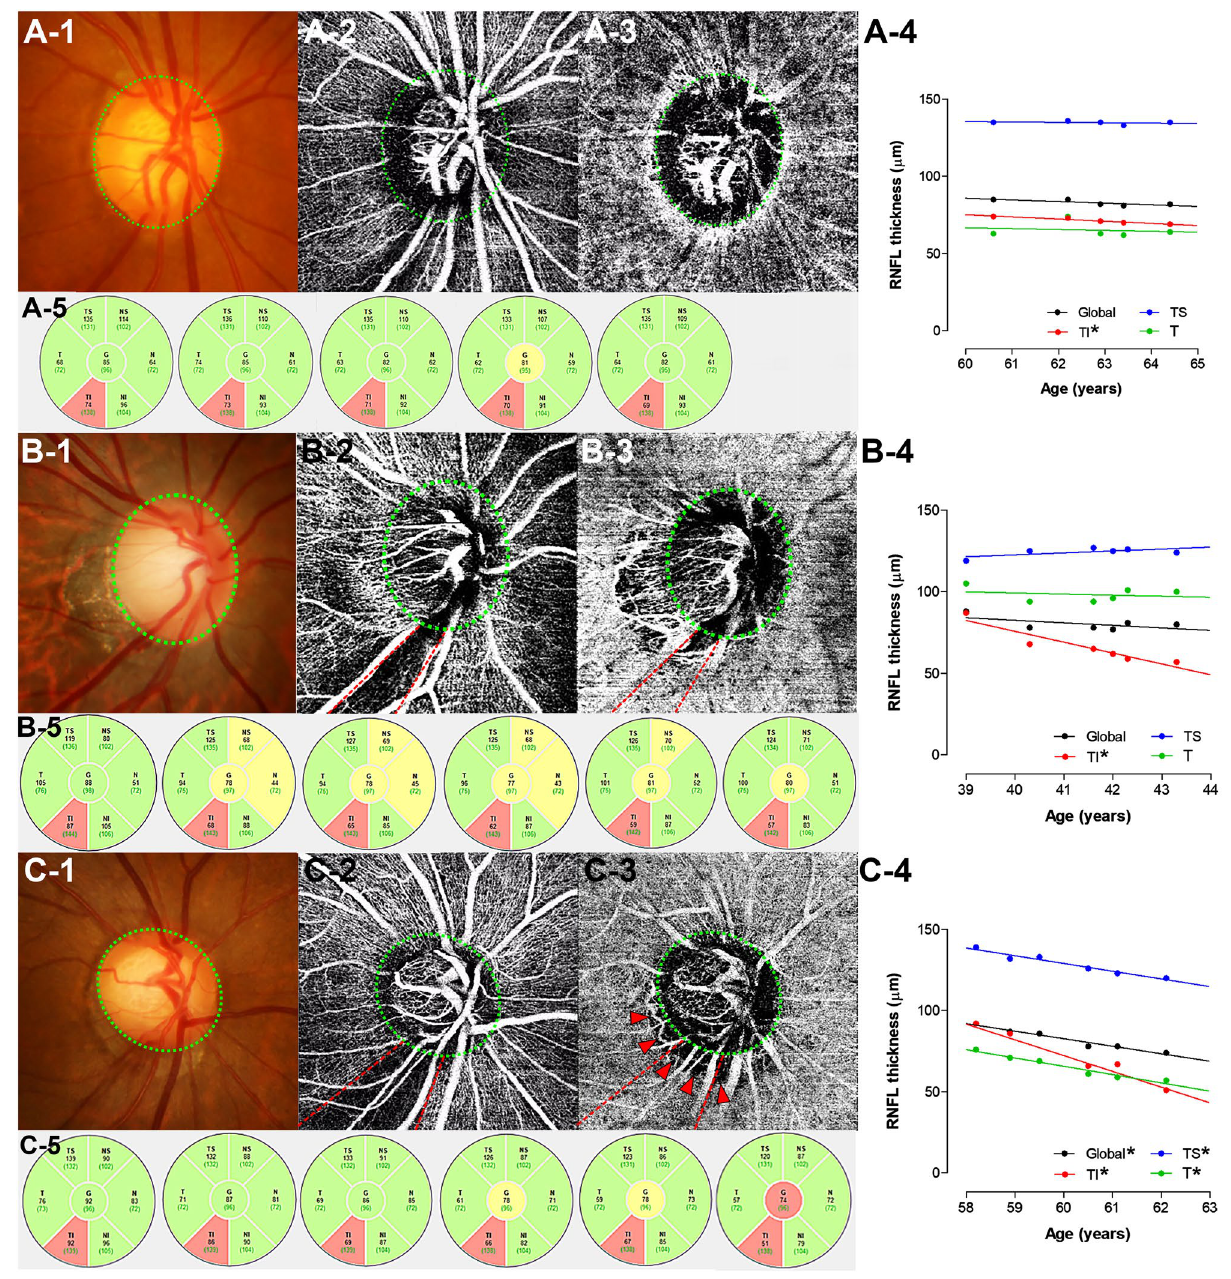
Figure 4. Representative eyes with primary open-angle glaucoma ( A ) without a CMvD, ( B ) with a CMvD width similar to the RMvI width, and ( C ) with a CMvD width larger than the RMvI width. ( A-1 , B-1 , C-1 ) Color disc photographs, ( A-2 , B-2 , C-2 ) En face OCTA images of the retinal and ( A-3 , B-3 , C-3 ) choroidal layers. Green dashed ellipses indicate margins of the optic discs. Red dashed lines and arrowheads indicate borders of RMvIs and CMvDs, respectively. ( A-4 , B-4 , C-4 ) Graphs showing the rate of RNFL thinning globally and in the TS, T, and TI circumpapillary sectors. Asterisks indicate the rates of RNFL thinning with statistical significance. The rates of RNFL thinning were relatively low in all sectors of eyes without CMvD ( A-4 ), but were significantly higher in eyes with CMvD ( B-4 , C-4 ). Note that the eye with CMvD width similar to RMvI width showed significantly rapid RNFL thinning at the location of the CMvD and RMvI ( B-4 ), whereas the eye with CMvD width larger than RMvI width also showed rapidly progressive RNFL thinning outside the RMvI ( C-4 ). ( A-5 , B- 5 , C-5 ) Serial OCT sectoral RNFL thickness map. Numbers represent RNFL thickness in micrometers. TS temporal-superior, T temporal, TI